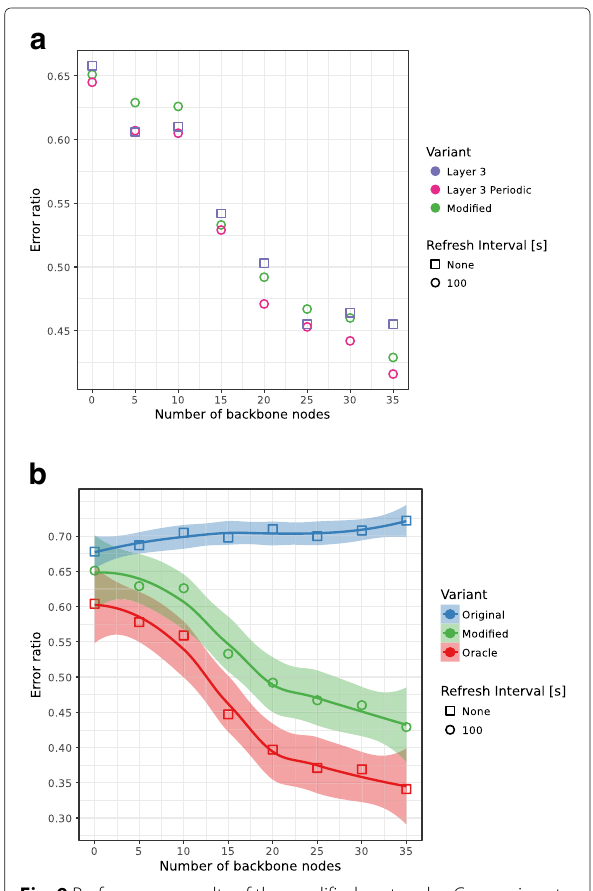
Fig. 9 Performance results of the modified protocol. a Comparison to artificial traces b Comparison to previous